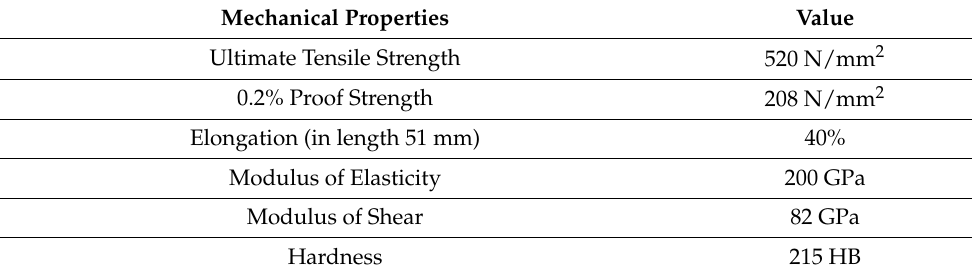
Table 2. Mechanical properties for stainless steel